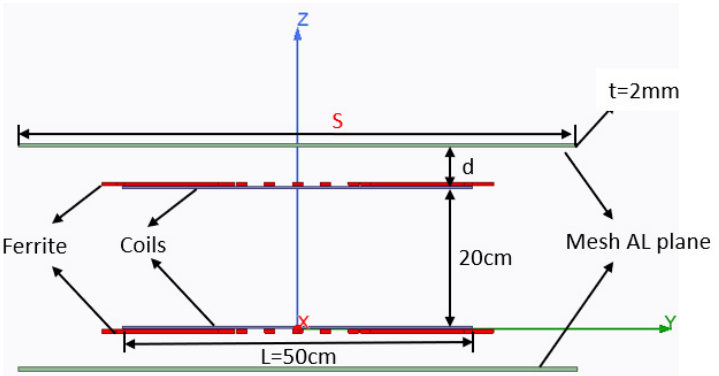
Figure 7. Schematic diagram of wireless transmission system for changing mesh aluminium plate size.